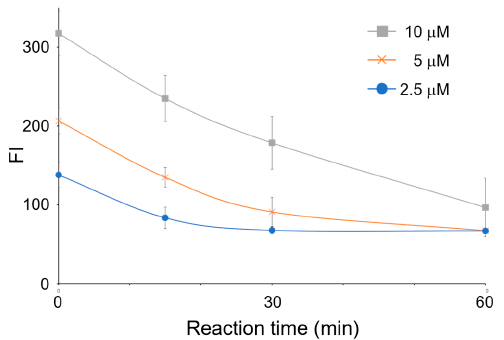
Figure 4. Time-dependent decrease in FL intensity on OPRT reaction. Different concentrations of orotic acid solutions were incubated with HeLa cell lysate, and a portion of the reaction mixture was allowed for the fluorogenic reaction with 4-TFMBAO. All experiments were repeated three times on different days.